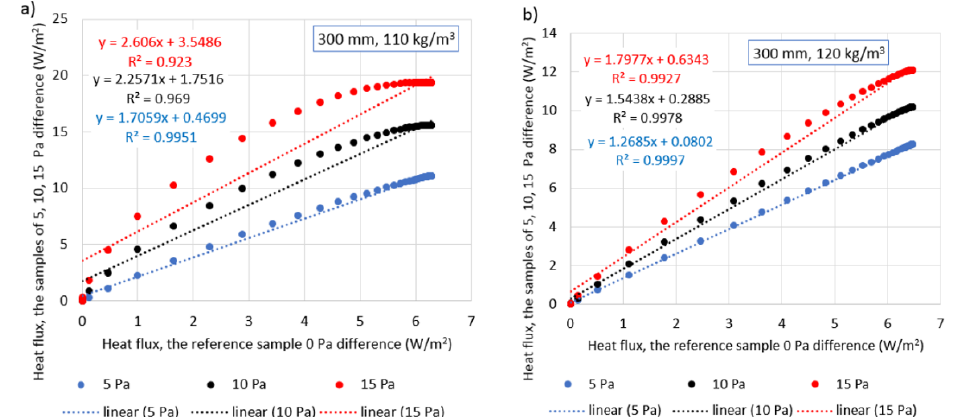
Figure 14. Comparison of the dependence of the heat flux in a wall with 300 mm insulation thickness on the pressure difference in the form of a comparison of the reference variant (0 Pa) with the variants characterized by a pressure difference of 5, 10 and 15 Pa, for a density of 110 kg/m 3 ( a ) and 120 kg/m 3 ( b ).